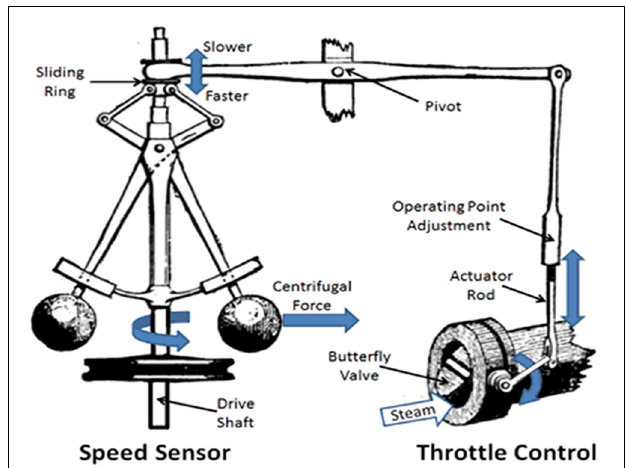
FIGURE 4 | Schematic representation of James Watt’s steam engineer flyweight governor. See text for details. Source: public domain, as modified from,